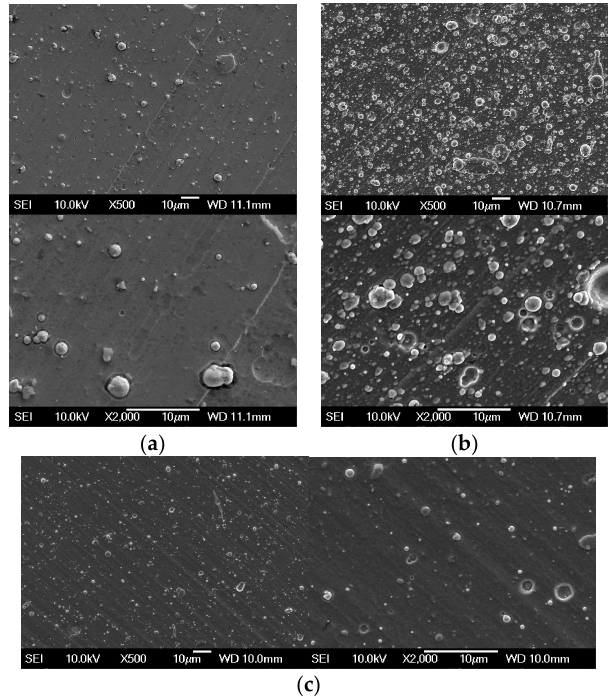
Figure 2. Surfaces of: ( a ) ZrN; ( b ) TiCN MP and ( c ) CrN coatings.